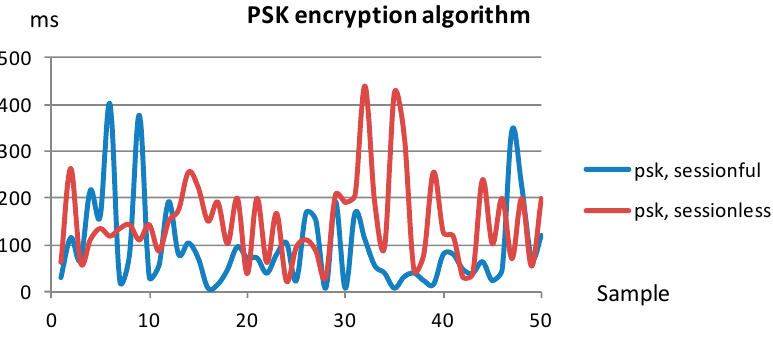
Figure 19. Performance measurements with symmetric data Figure 19 . Performance measurements with symmetric data encryption. Figure 19 . Performance measurements with symmetric data encryption.